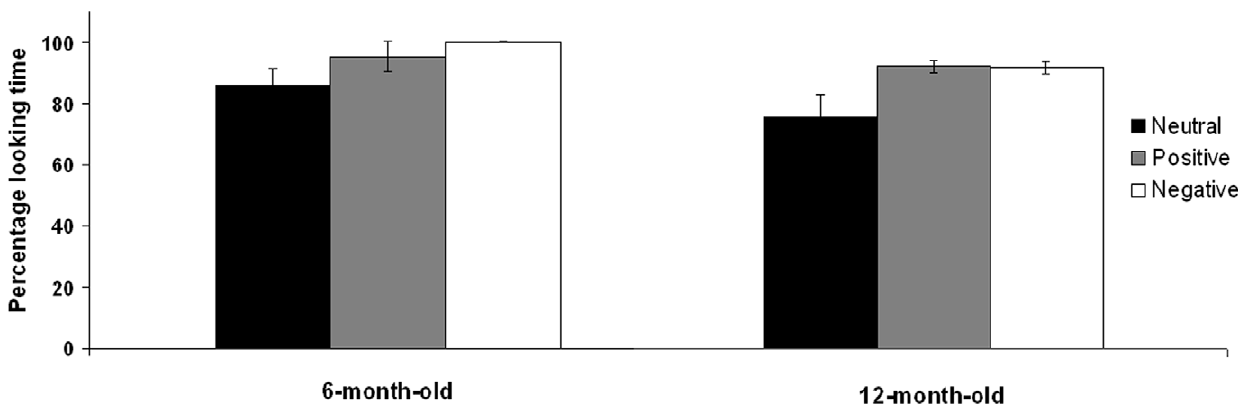
Figure 2. Looking time to the peer ’ s face. Looking time to the peers’ faces during the neutral (black), positive (gray), and negative (white) emotional display was computed as percentage from the total looking time towards the stimulus. Error bars represent SE s.